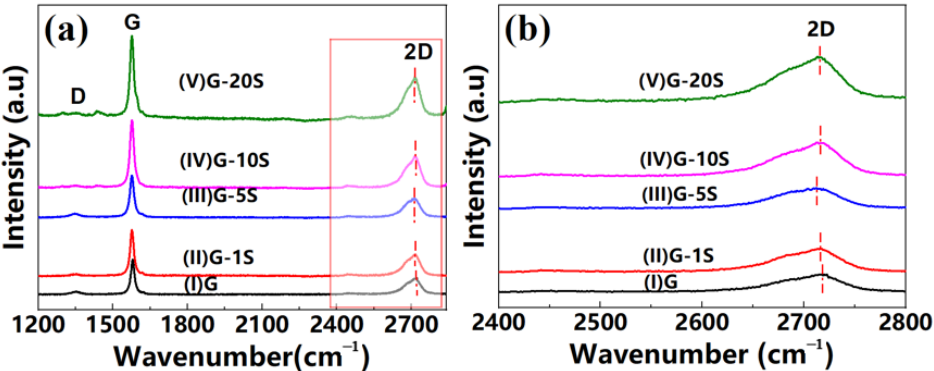
Figure 3. ( a ) Raman spectra of G, G-1S, G-5S, G-10S, and G-20S and ( b ) magnified Raman images recorded from ( a ).